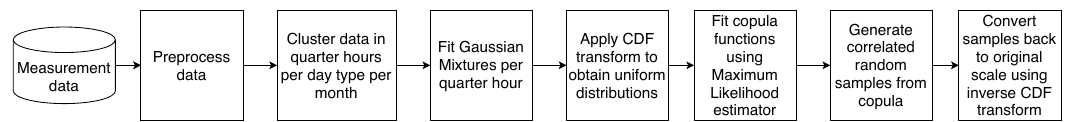
Figure 1. Diagram of the steps for generating the correlated load